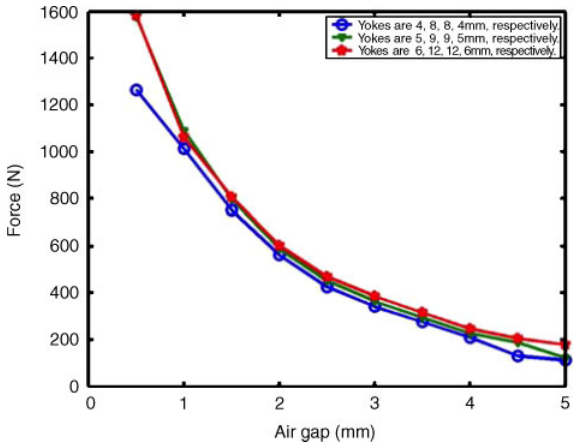
Figure 8 Influence of thickness of the yokes.